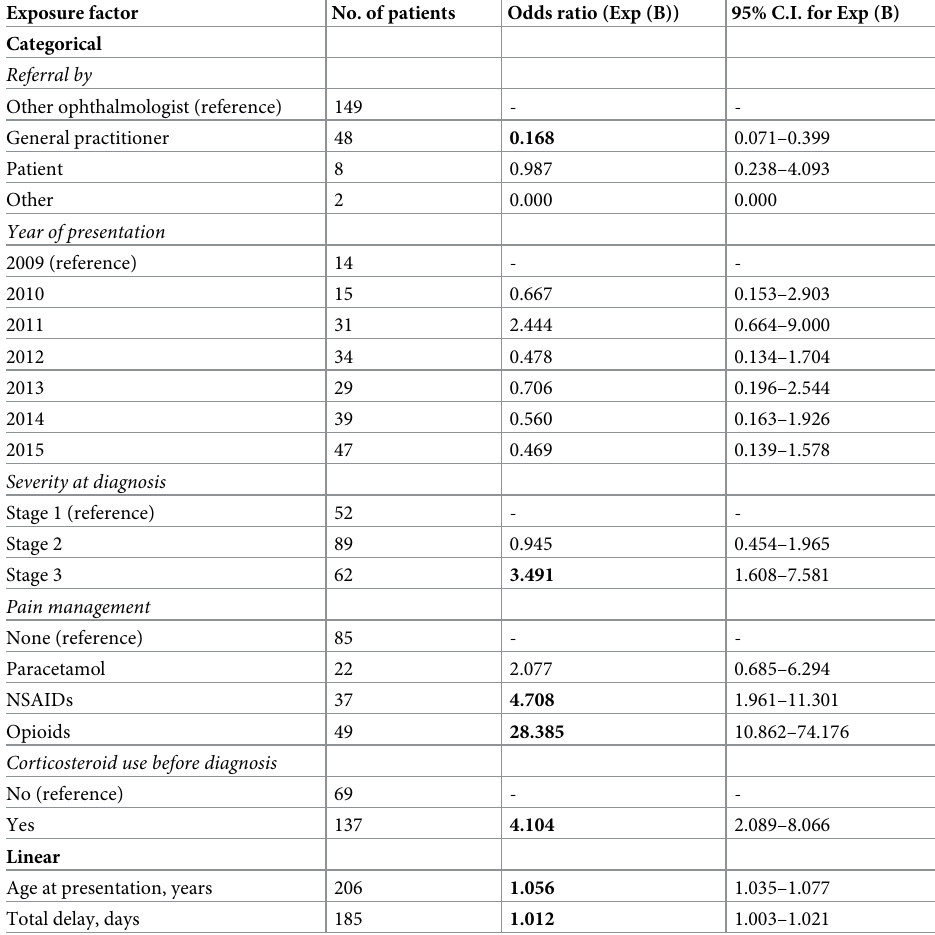
Table 3. Univariable logistic regression analyses on ‘treatment failure’ �